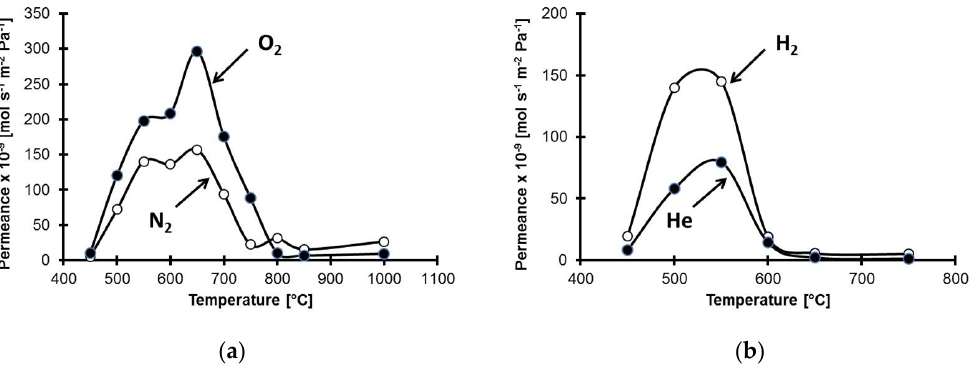
Figure 3. ( a ) O 2 and N 2 permeance of membranes just after carbonization, ( b ) H 2 and He permeance after 1 day aging. Reproduced with permission from [51], Elsevier, 2014.